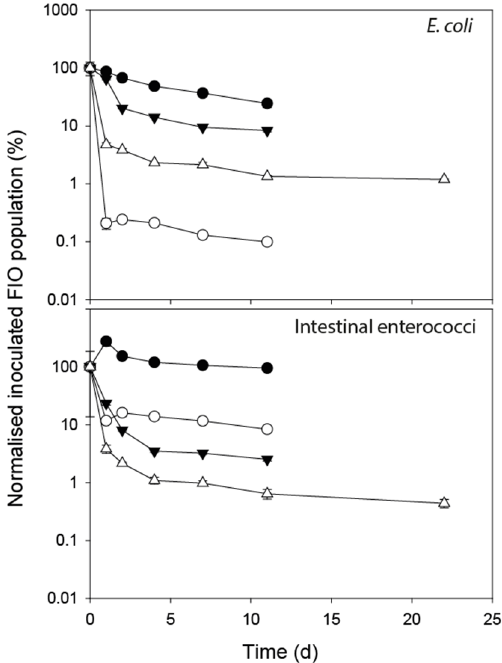
Figure 3. Normalised die-off profiles of faecal indicator organisms (FIOs) inoculated into water undergoing freeze–thaw (F–T) cycles: isolated from dairy cow faeces held at − 4 ◦ C F–T (solid black circles) and − 8 ◦ C F–T (solid black triangle); isolated from red deer faeces held at − 4 ◦ C F–T (open circles) and − 8 ◦ C F–T (open triangles). Data points show mean of 3 replicates ± standard